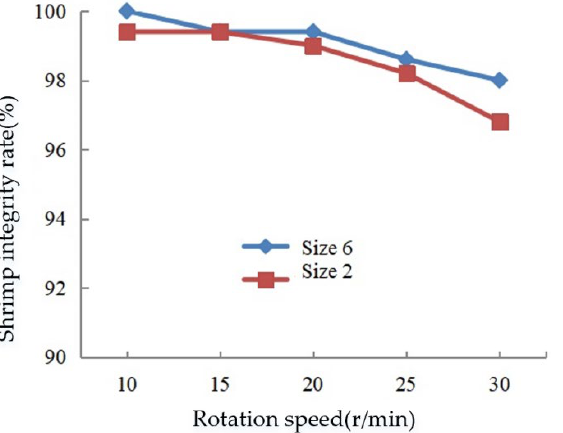
Figure 24. Relationship between shrimp integrity rate and rotation speed.